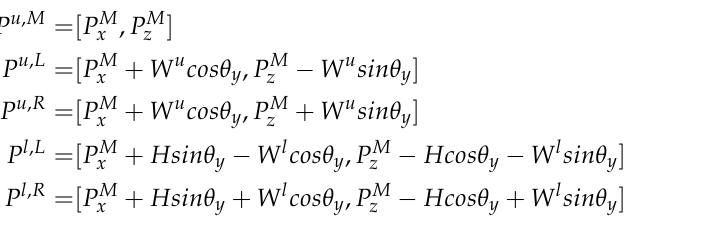
Figure 5. System projected in two dimensions in the y-axis